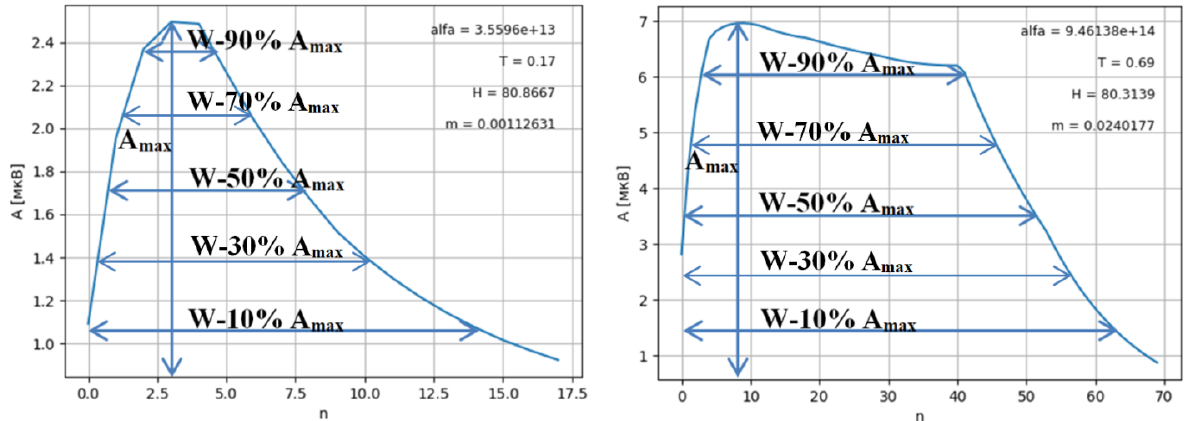
Figure 4. Indicators for